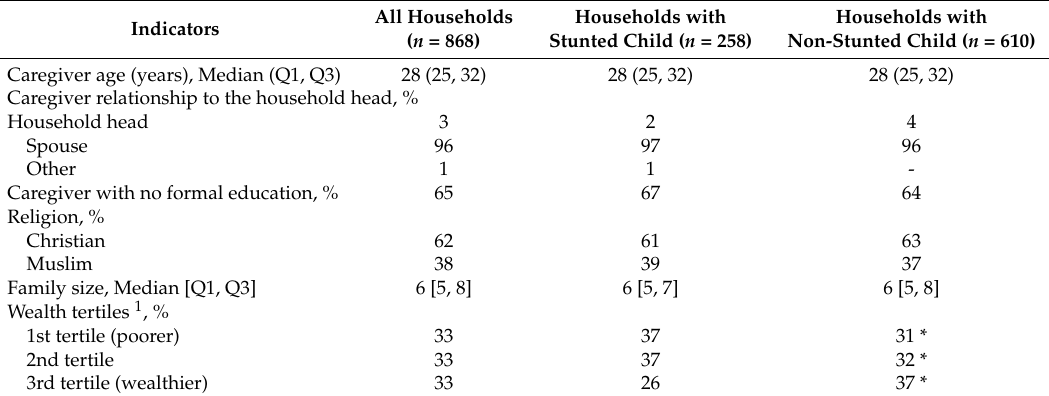
Table 1. Socioeconomic and demographic characteristics of participating